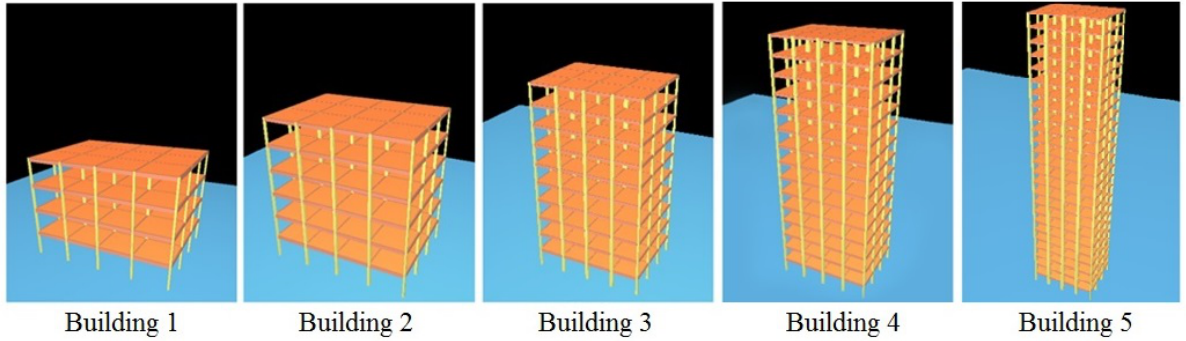
Figure 5. Regular buildings.